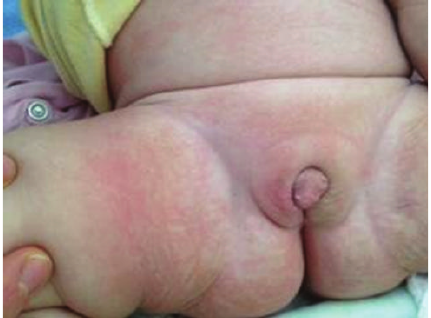
Figure 1: The external genitalia appeared to be significantly virilised (Prader stage 3).